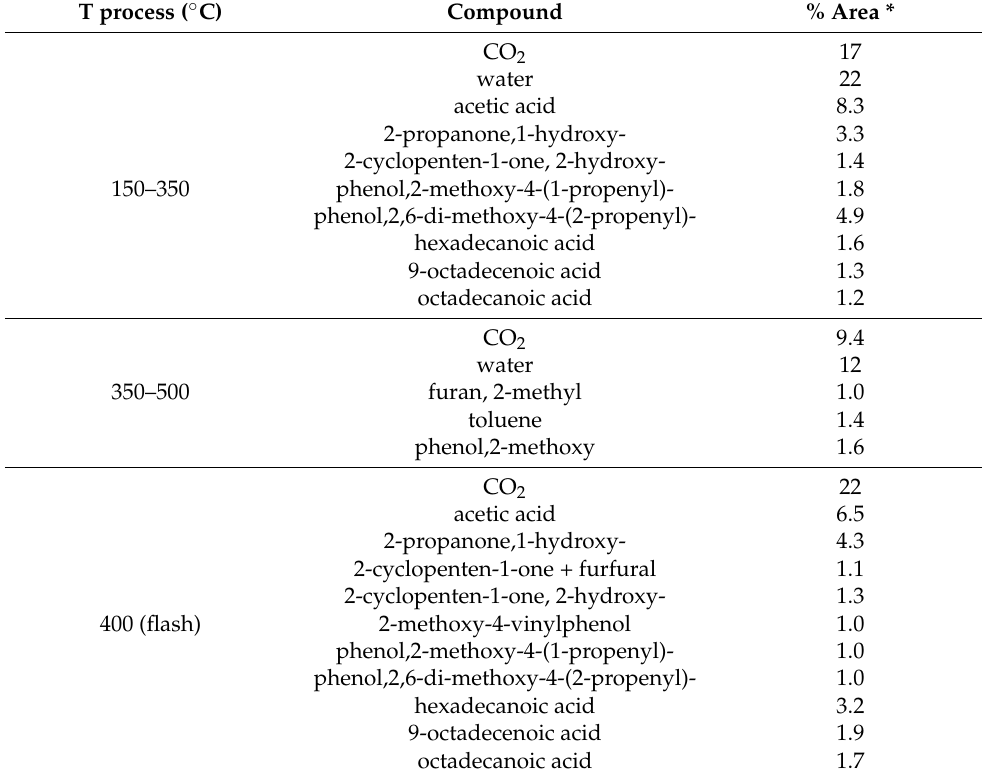
Table 4. Area percentage of main